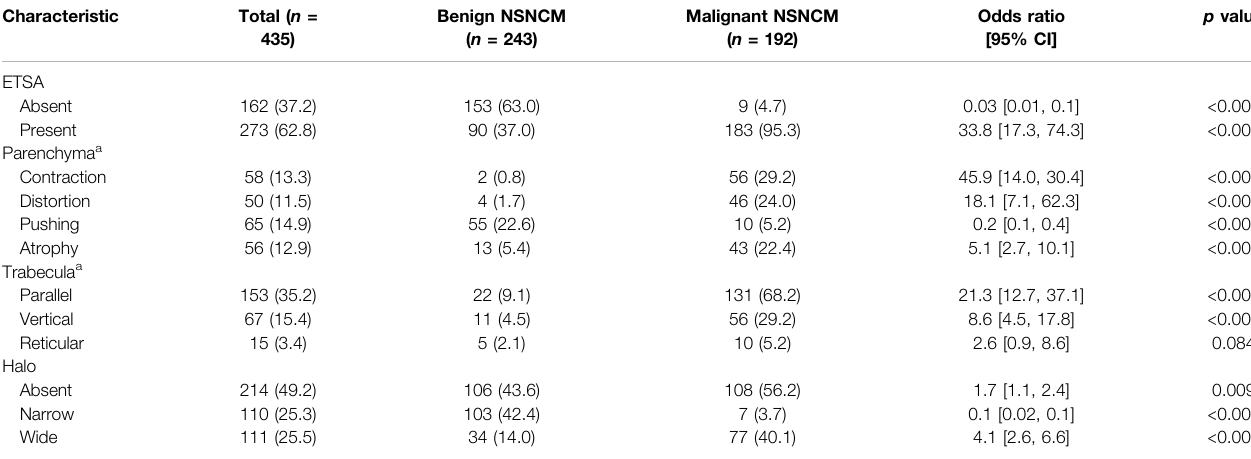
TABLE 2 | Univariate analysis of extratumoral signs between benign and malignant NSNCMs.